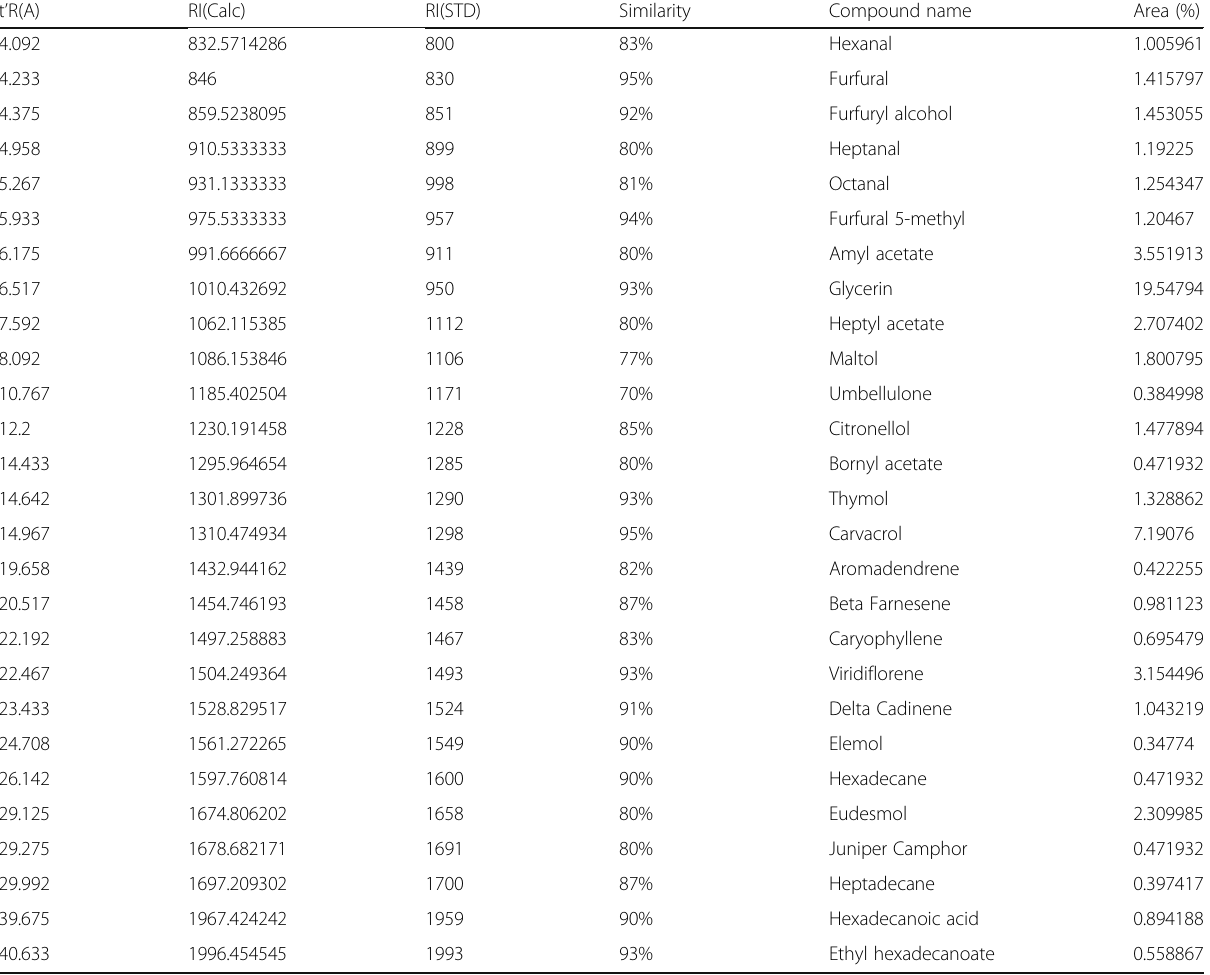
hexadecanoate, and